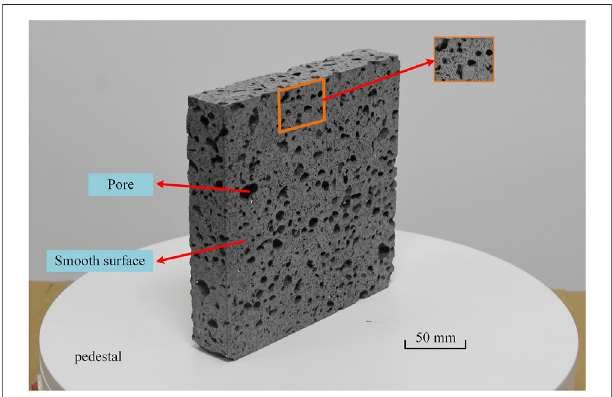
FIGURE 1 | Diagram of volcanic rock specimens.